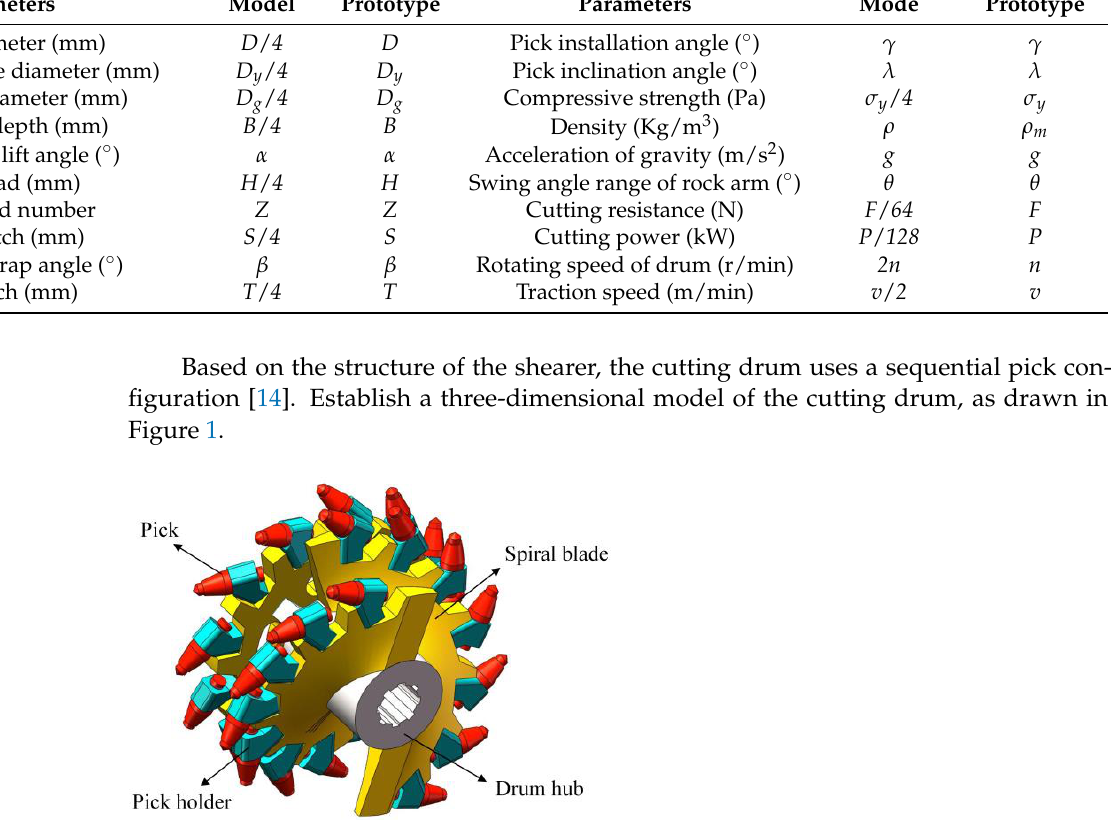
Figure 1. Three-dimensional model of the cutting drum.